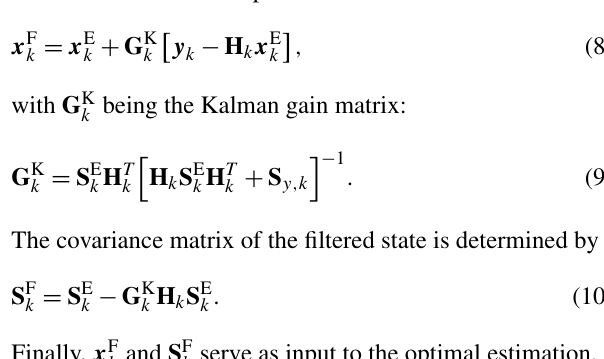
Table 1. Forward model error for each frequency due to different absorption codes. Uncertainties are given as square root of the di- agonal elements of the covariance